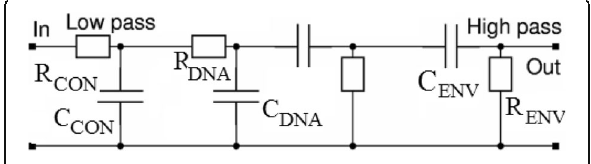
Fig. 2 Equivalent electronic circuits of DNA molecule at different frequency ranges